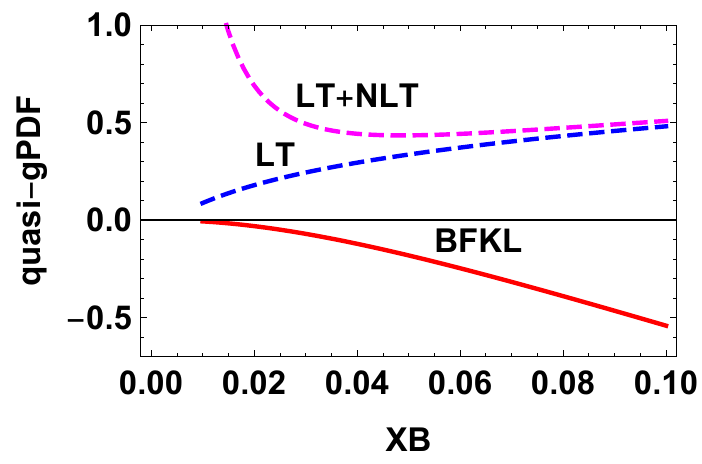
Figure 11 . Here we plot the quasi-PDF with BFKL rsummation eq. (8.3) (real part), the LT and the LT+NLT of eq. (8.6) (real part). The curves are plotted in the range x B ∈ [0 . 01 , 0 . 1] with P ξ = 4